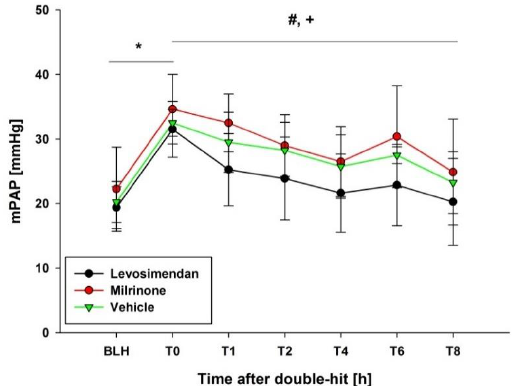
Figure 3. mPAP. * indicates p < 0.05 BLH vs. T0 for all groups. # indicates p < 0.001 levosimendan vs. milrinone. + indicates p < 0.05 levosimendan vs. vehicle. mPAP: mean pulmonary arterial pressure. BLH: baseline healthy. Tx: timepoint. h: hours.